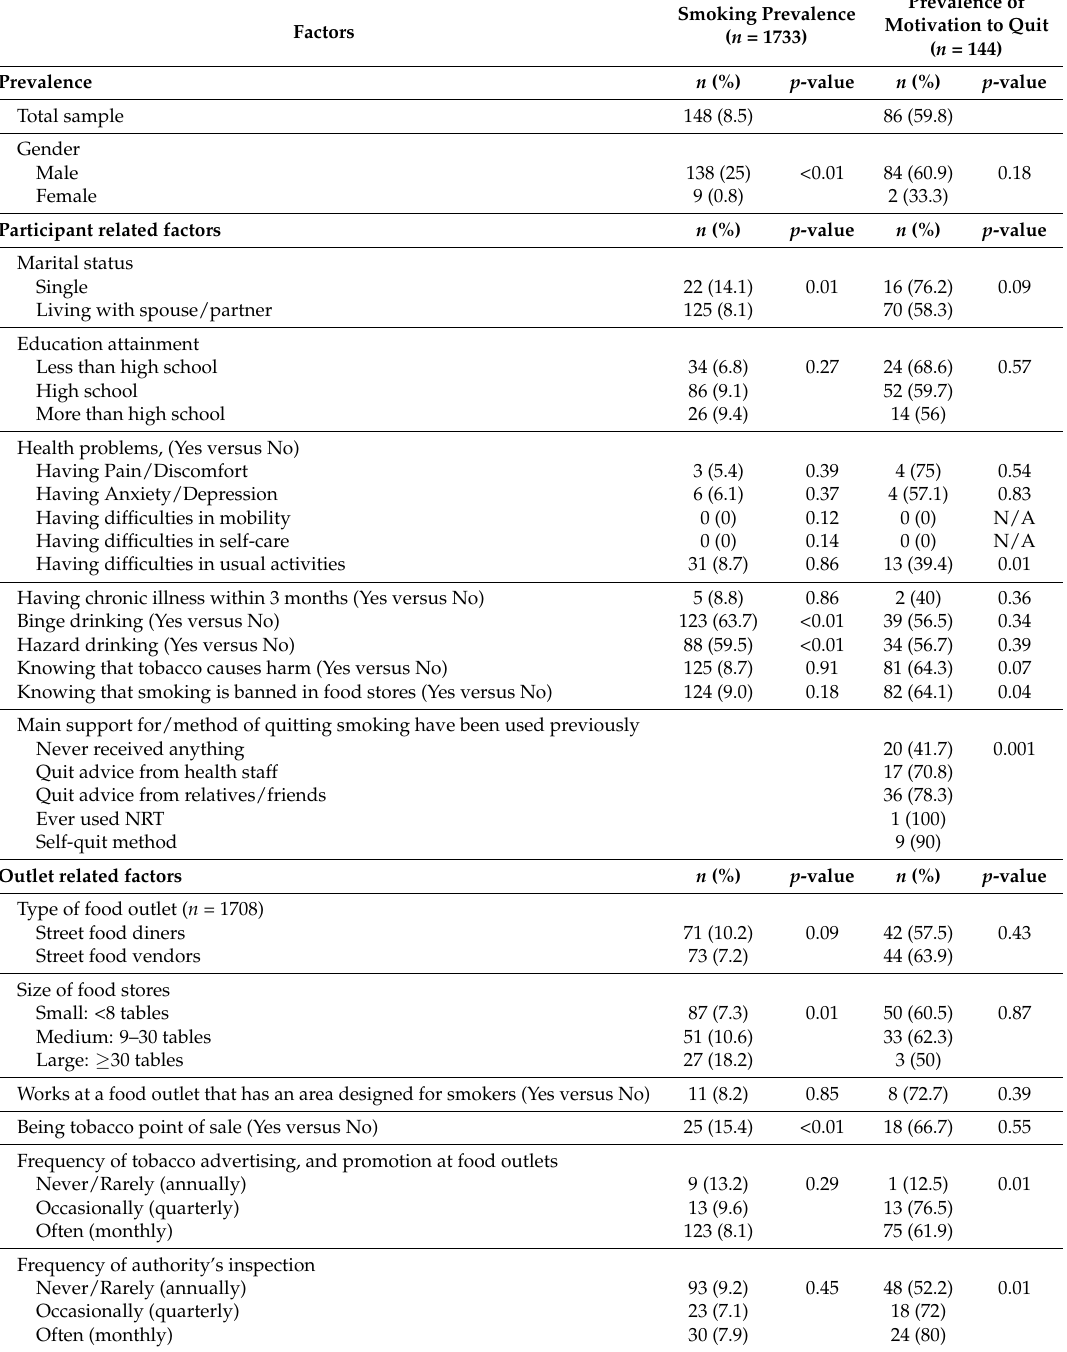
Table 2. Prevalence of smoking and prevalence of motivation to quit by factors among food sellers. Factors